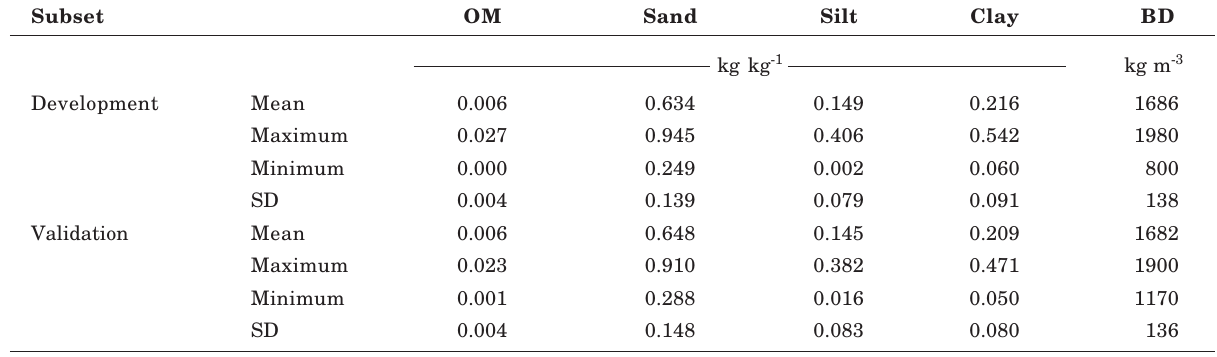
Table 2. Descriptive statistics (mean, maximum, minimum and standard deviation - SD) for organic matter (OM), sand, silt, clay contents and bulk density (BD), for the PTF development ( N = 673) and validation